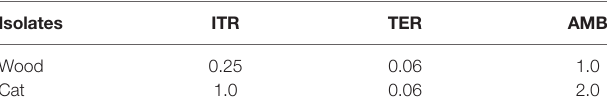
TABLE 2 | MICs (mg/L) of the S. brasiliensis strains evaluated in this study. Isolates ITR TER AMB